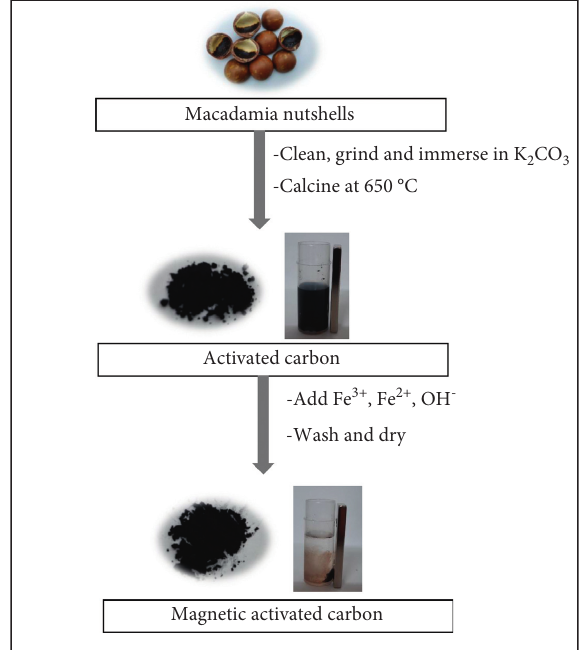
Figure 1: Schematic representation of the synthesis of magnetic AC derived from macadamia nutshells.